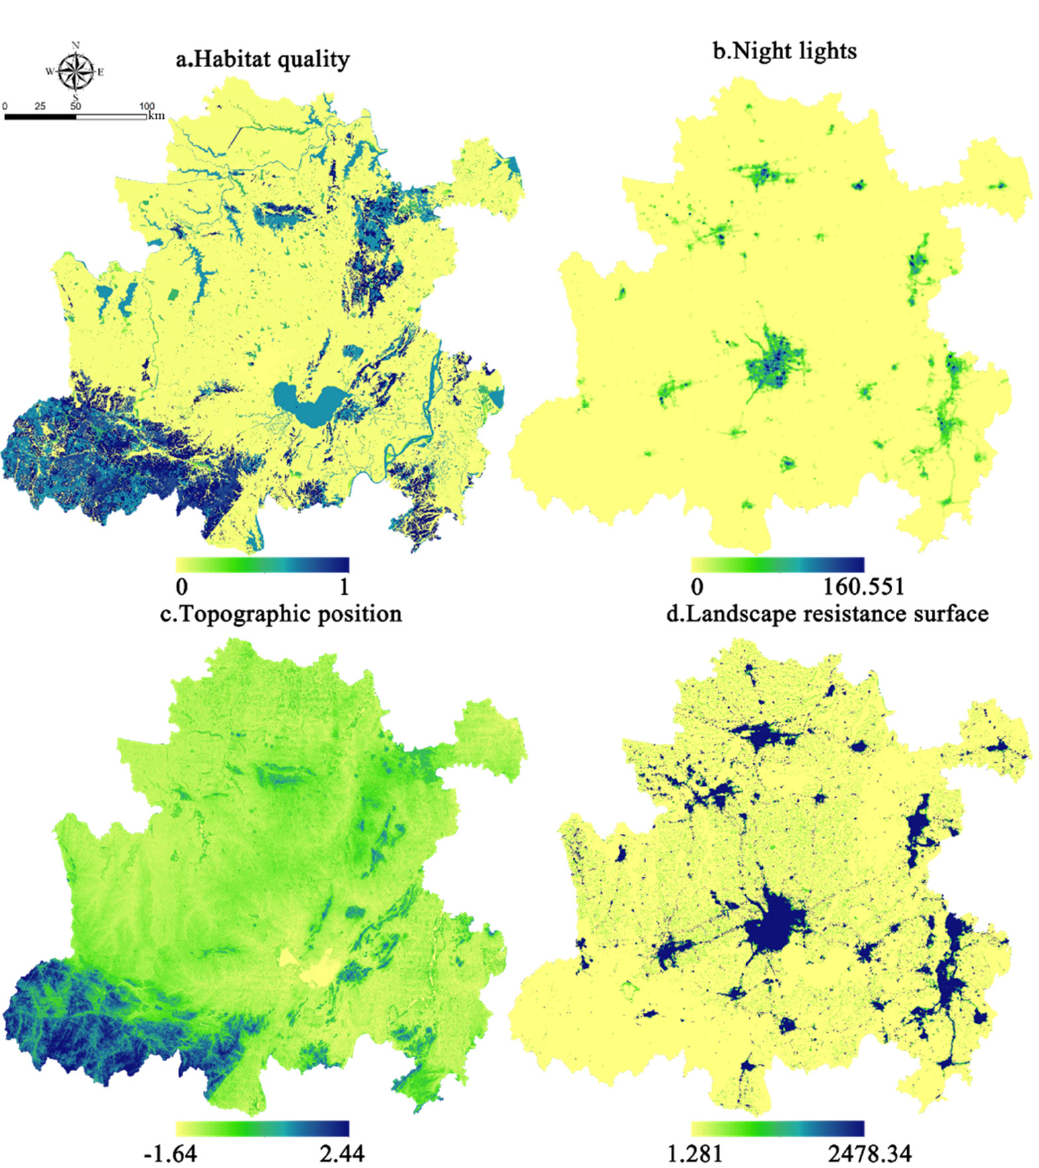
Figure 3. Landscape resistance surface and its constituent factors.